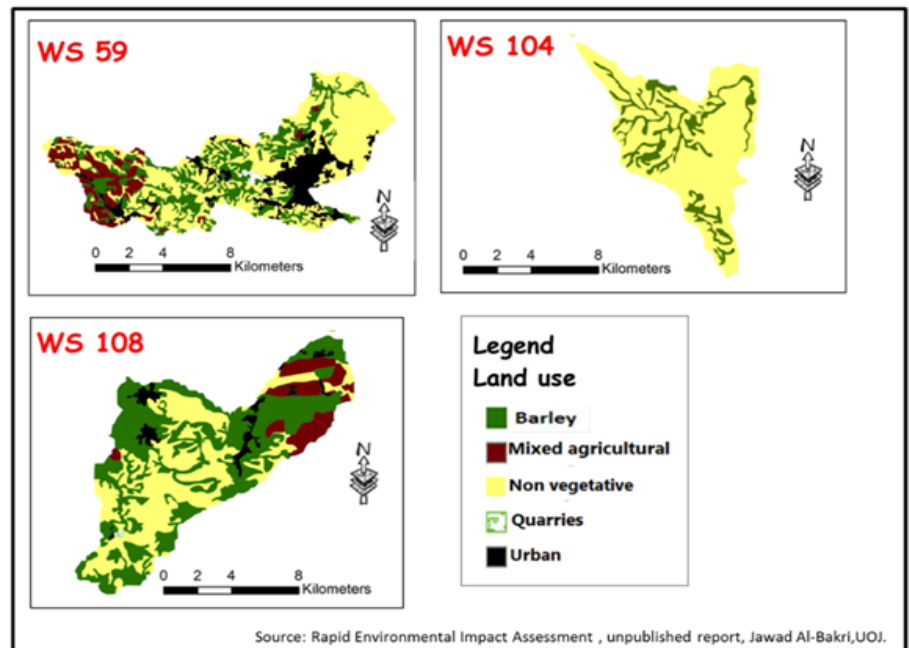
Figure 2. Land use satellite imagery for WS 59, WS 104 and WS